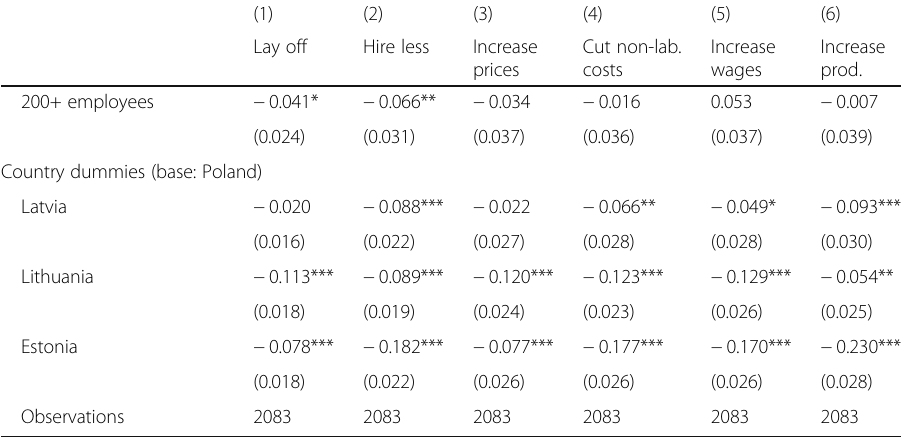
Table 5 Multivariate probit model of the relevance of adjustment channels, average marginal effects (all channels; sample restricted to the Baltic countries and Poland) (Continued) (1) (2) (3) (4) (5) (6) Lay off Hire less Increase Cut non-lab. Increase Increase prices costs wages prod. 200+ employees − 0.041* Country dummies (base: Poland) Latvia − 0.020 − 0.088*** − 0.022 − 0.066** (0.016) Lithuania − 0.113*** − 0.089*** Estonia Observations